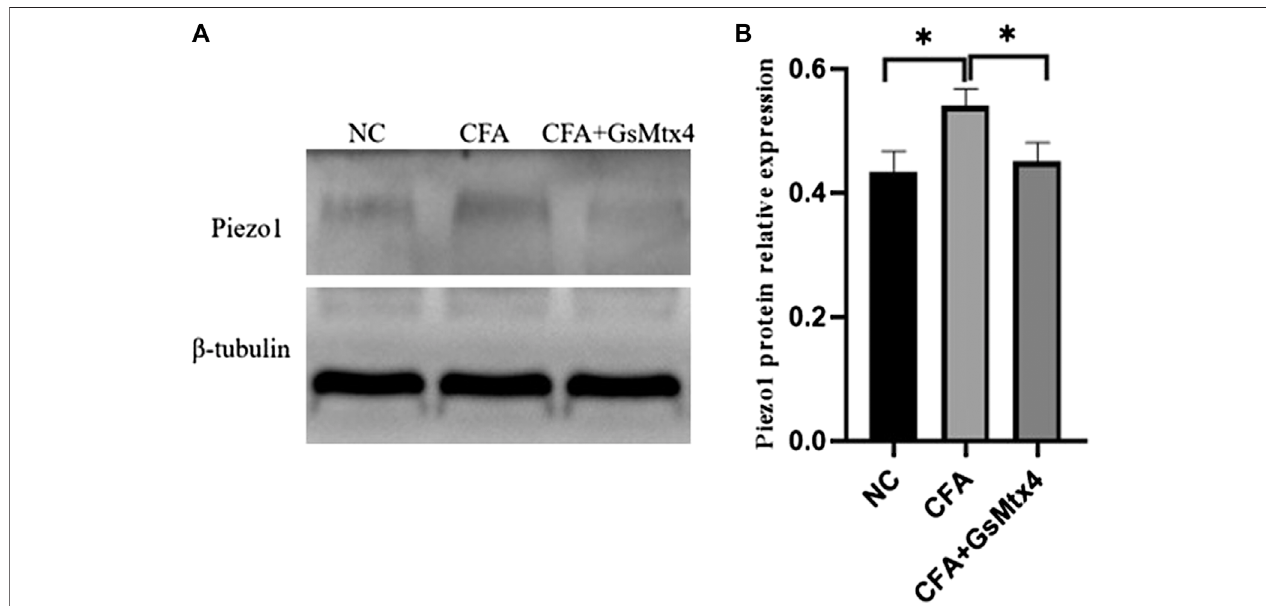
FIGURE 7 | (A) Piezo1 expression in each group. (B) Statistical analysis of the Piezo1 expression in each group. * p < 0.05.